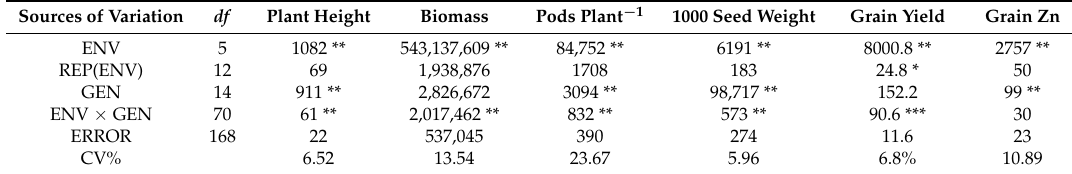
Table 1. Analysis of variance table showing mean squares (MS) of the effect of ENV (site-year) and their interaction on plant height, biomass, pods plant − 1 , seed weight, and grain zinc concentration across 15 chickpea cultivars and breeding lines